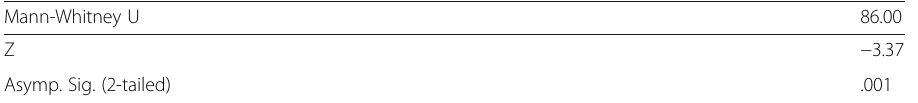
Table 13 Test statistics for the feedback receiver group and control group in the picture description